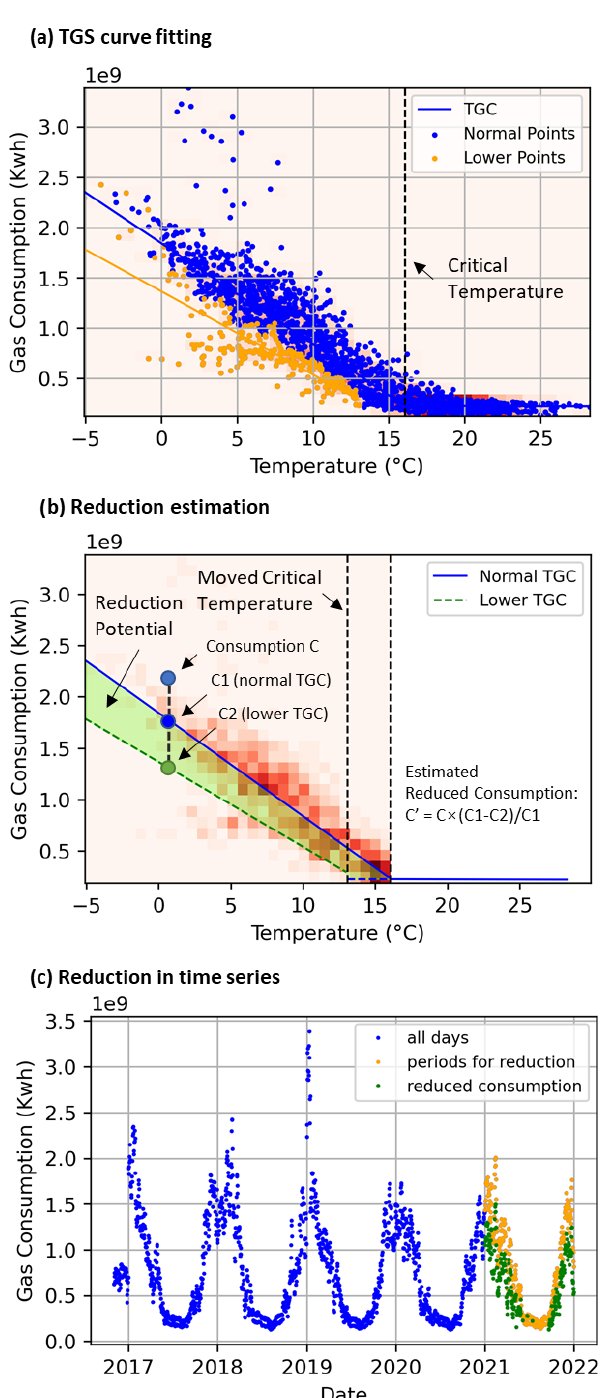
Figure 2. Example of temperature–gas consumption (TGC) curves and estimated reduced consumption. The figure panels show an ex- ample of house heating reduction estimations for France, outlining (a) TGC curve fitting for normal consumption and the lower 20% percentile of consumption, (b) how the consumption reduction was estimated for each daily data point, and (c) the estimated heating reduction time series from 2021 to